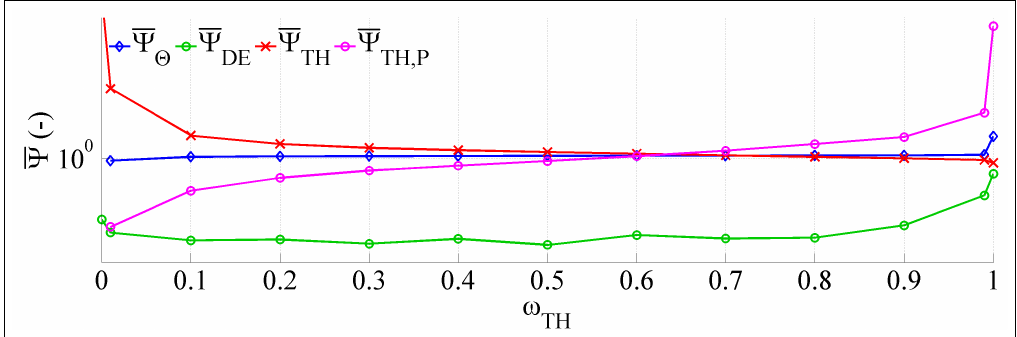
Figure 14. The criteria function member values as the function of ω TH